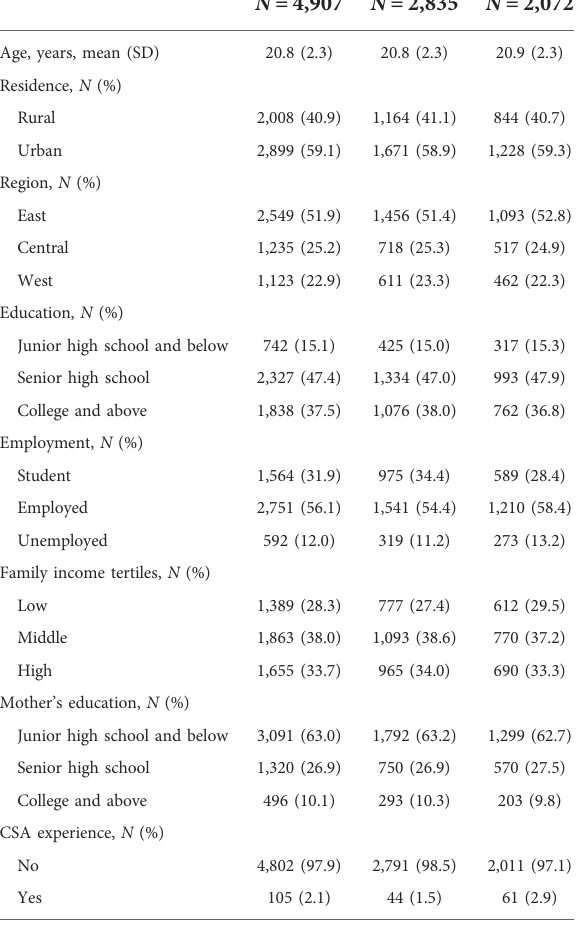
TABLE 1 Characteristics of the study sample by